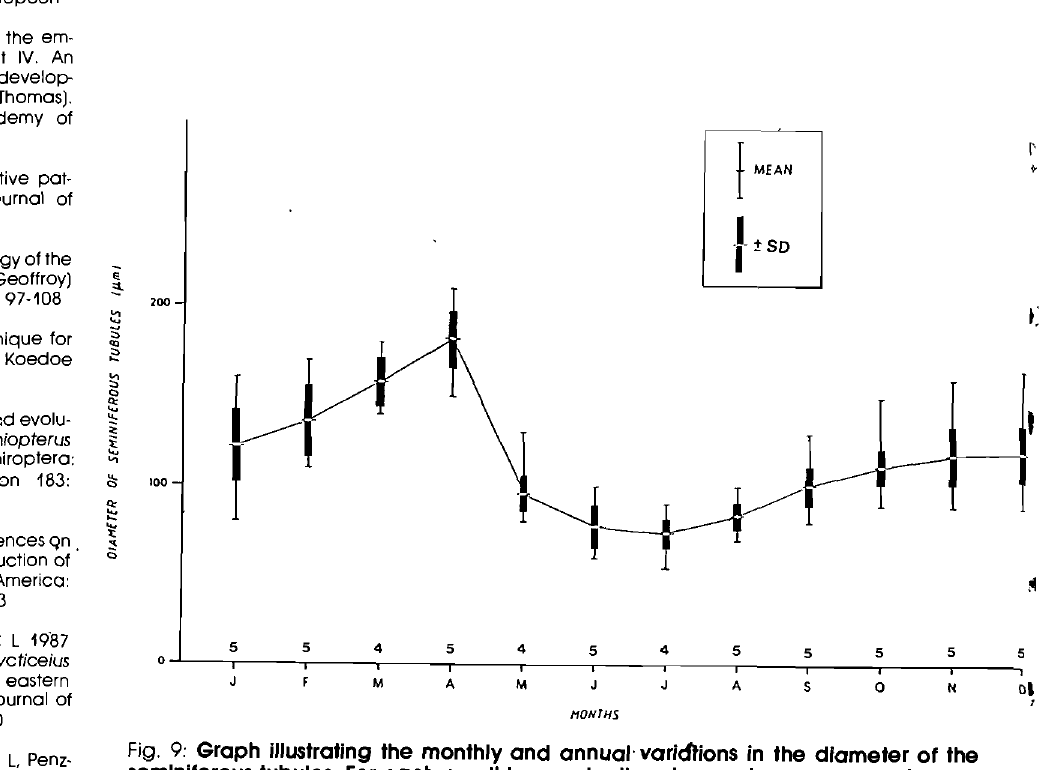
Fig. 9: Graph illustrating the monthly and annual'varidtions in the dIameter of the seminiferous tubules. For each monthly sample, the observed ranges are Indicated by a verticalli~e, the mean is indicated by a horizontal line bisecting the vertical line, and plus or minus one standard deviation of the mean is indicated by a solid rec tangle. The numbers indicate the total number of specimens examined each month